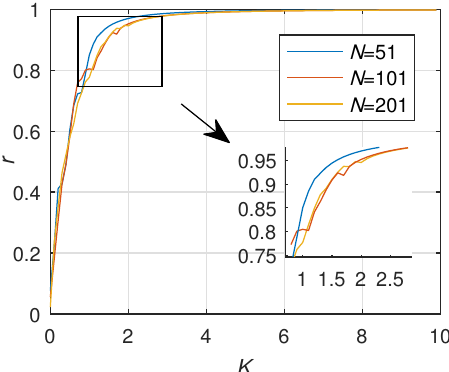
Figure 16. The stability of the weighted undirected network when N is 51,101,201( β =